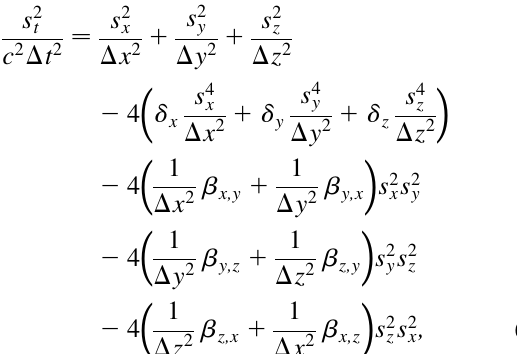
FIG. 6. Position of the nodes used to compute r (cid:7) our modified scheme.